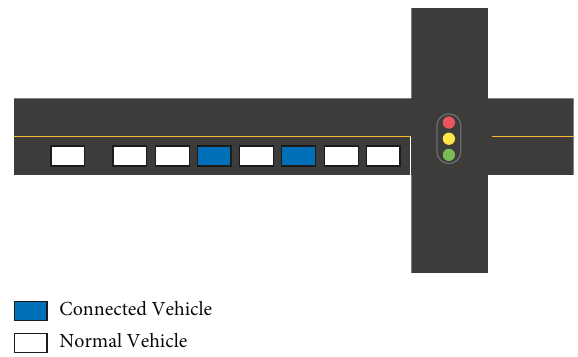
Figure 1: Illustration of queued vehicles at an intersection. Table 1: Summary of